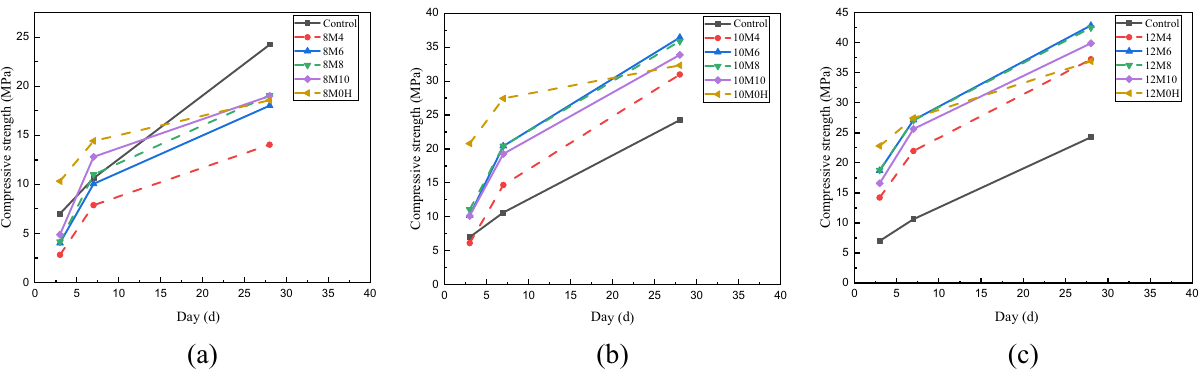
Figure 9: Compressive strength of fl y ash - based geopolymer mortar ( with or without nano - SiO 2 ) with di ff erent molarity [ 38 ] . ( a ) 8 M, ( b ) 10 M, and ( c ) 12